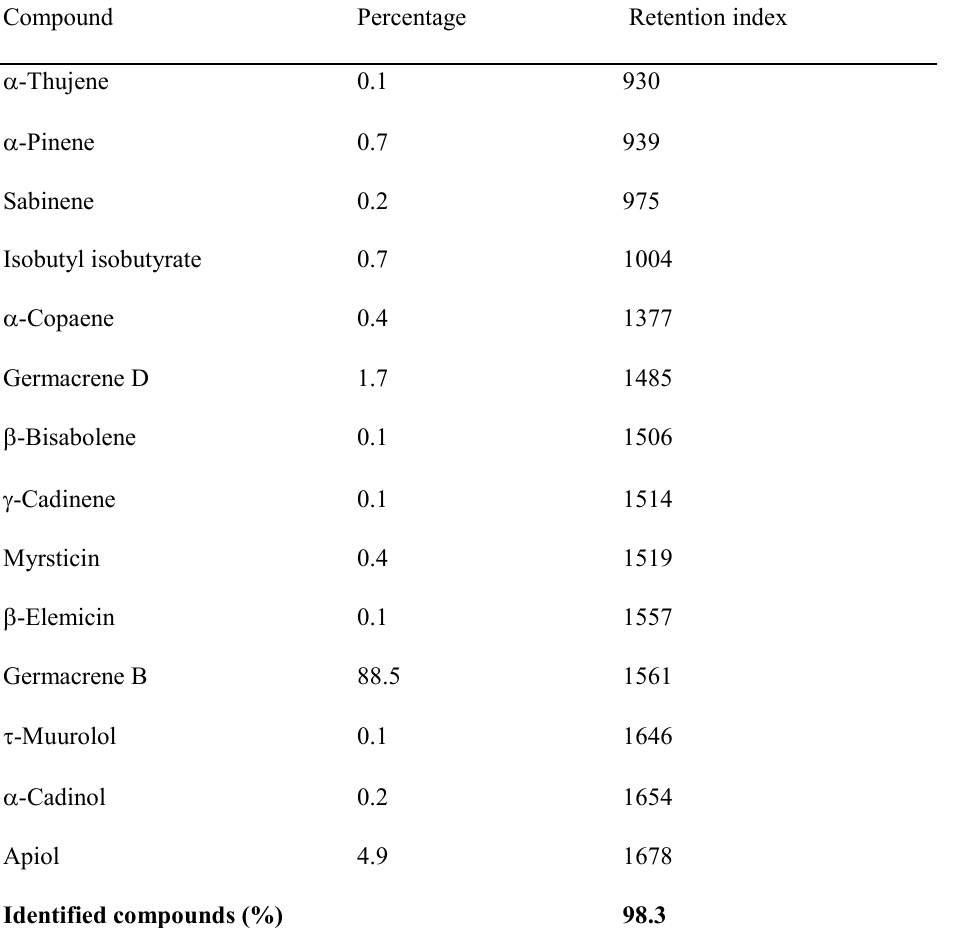
Table 1 . The composition of the volatile oil of Athamanta sicula L. from